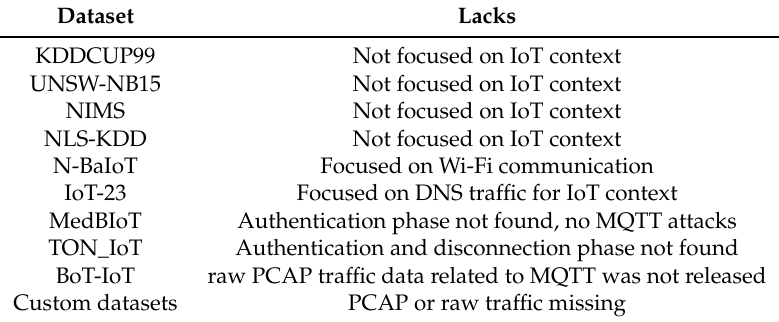
Table 1. Available IoT datasets adopted in detection approach.